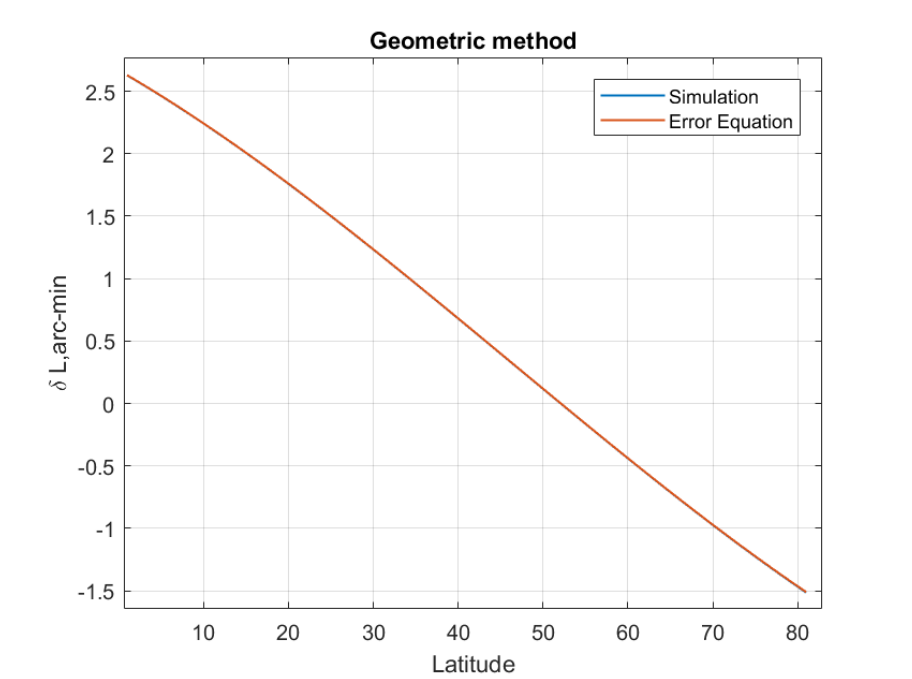
Figure 7. The latitude error of the geometric method with latitude